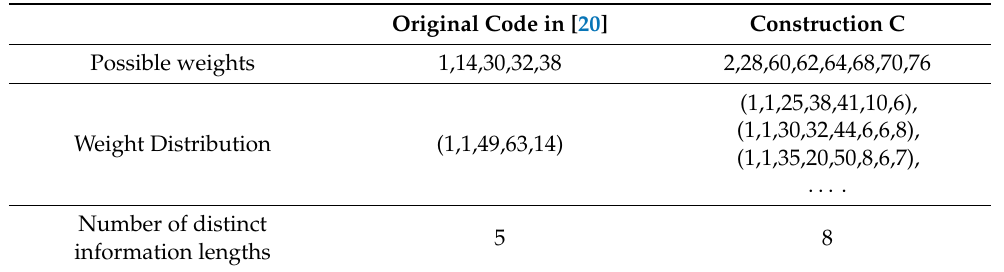
Table 3. An example of the weight distribution of the resultant code from Construction C (code length: